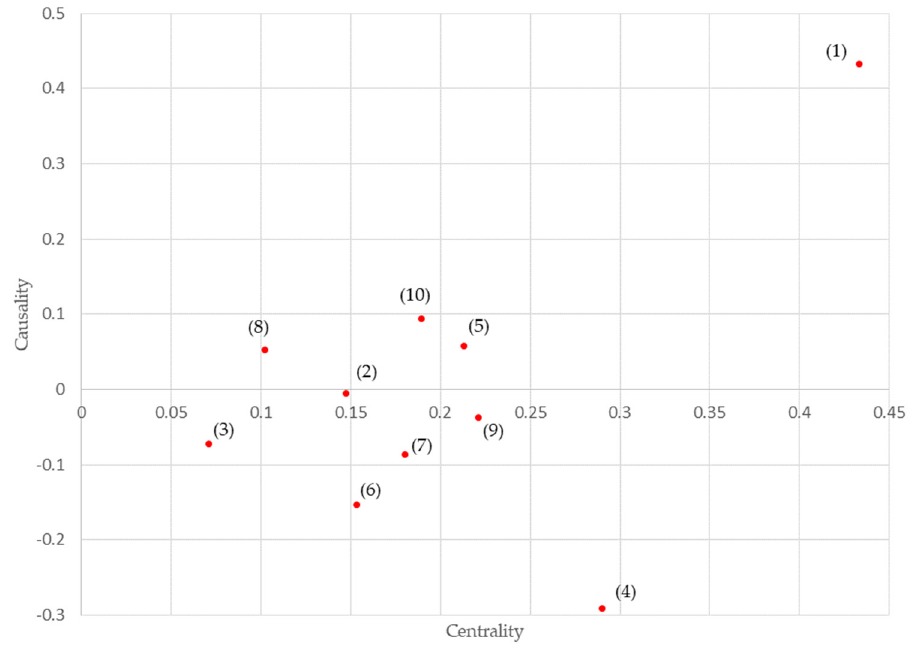
Figure 3. Graphs with Centrality and causality of elements identified by the decision-making trial and evaluation laboratory method. The meanings of the numbers in the figure are shown in Table 4.